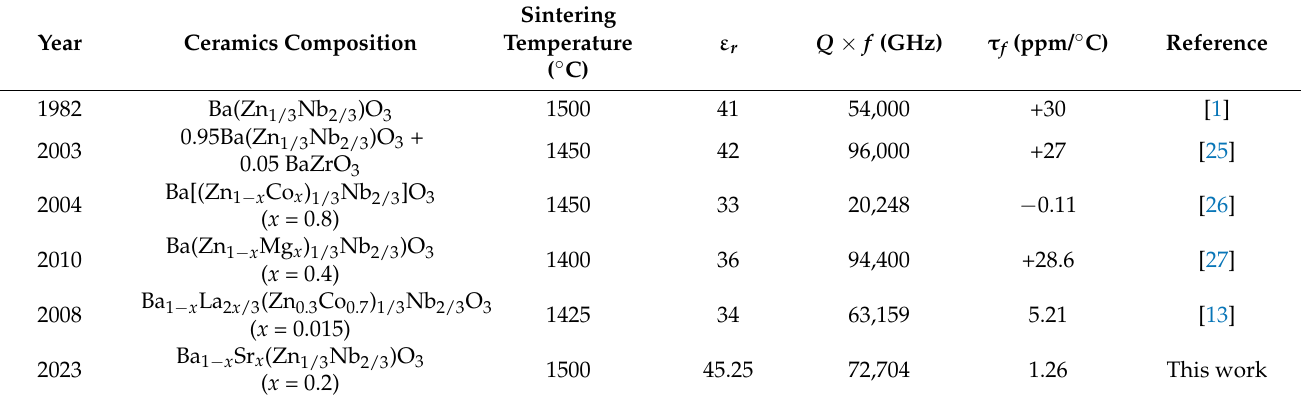
Table 6. The microwave dielectric properties of some typical Ba(Zn 1/3 Nb 2/3 )O 3 -based